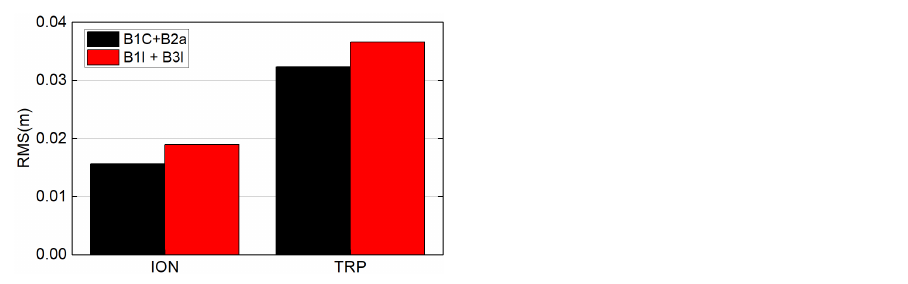
Figure 6. Comparison of average RMS of the DD solutions from different combinations of BDS-3 in WH04-HG02.